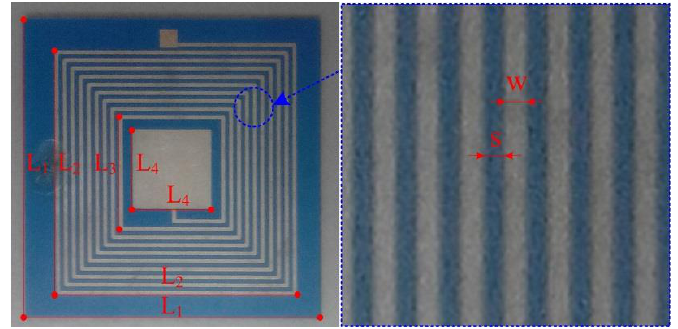
Figure 1. Main fabrication processes of the pressure sensor.